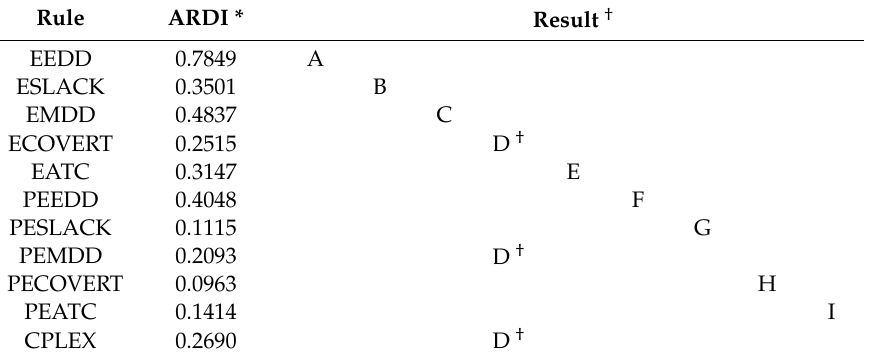
Table 5. Results of the Wilcoxon signed rank